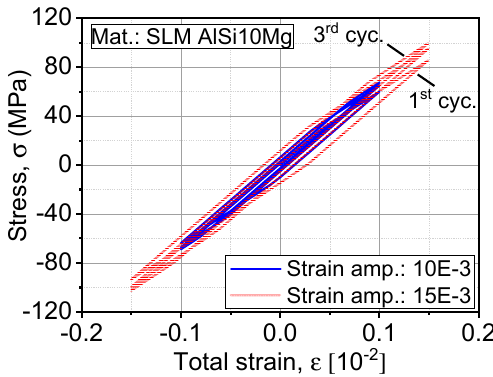
Figure 7. Expansion of hysteresis under the influence of increased strain as solved by the Armstrong–Frederick model.